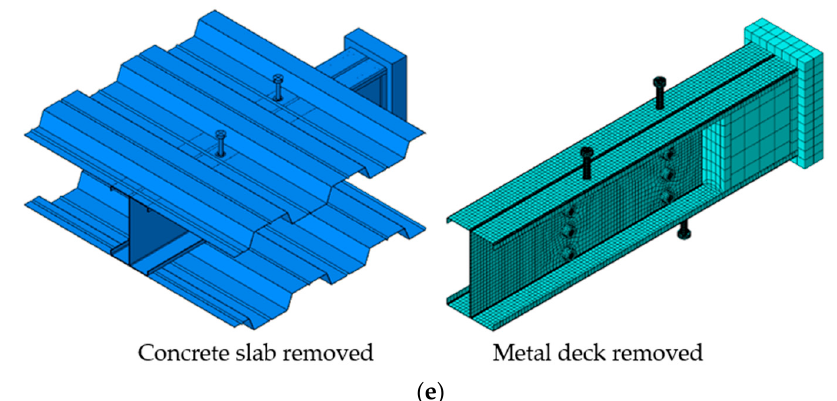
Figure 5. Finite element models of push tests. ( a ) Overall model; ( b ) Single Bracket Shear Connector (SBSC); ( c ) Double Bracket Shear Connector (DBSC); ( d ) Hot Rolled Plate Shear Connector (HPSC); ( e ) Standard headed Shear Connector (HSSC). Table 1. Materials Properties. Specimen